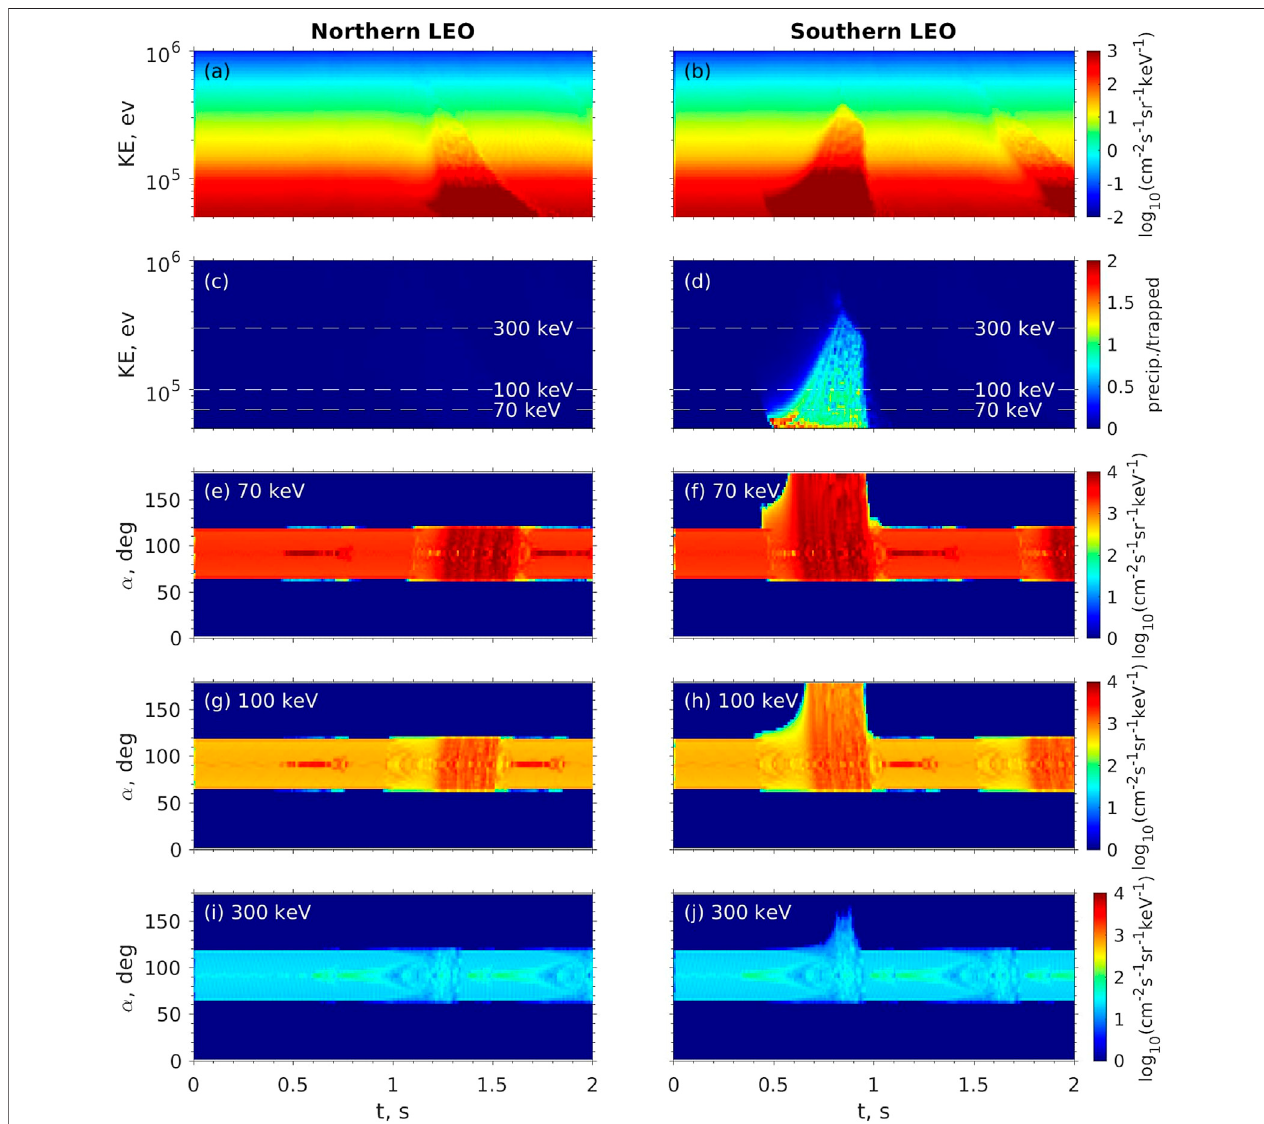
FIGURE3| Modeledelectron fl uxesatvirtualnorthern (leftcolumn) andsouthern (rightcolumn) LEOsatellitesduetothepresenceoftheductedwaveshownin Figure3 . (A,B) omni-directionaldifferential fl uxovertheenergy rangefrom50 keVto1 MeV. (C,D) theratioofprecipitatingandtrappedelectron fl uxesovertheenergy range from 50 keV to 1 MeV. Local pitch angle distribution of electron fl uxes at three selected electron kinetic energies (E, F) 70 keV, (G, H) 100 keV and (I, J) 300 keV. The three energies are also marked by the horizontal white dashed lines in panels c-d.